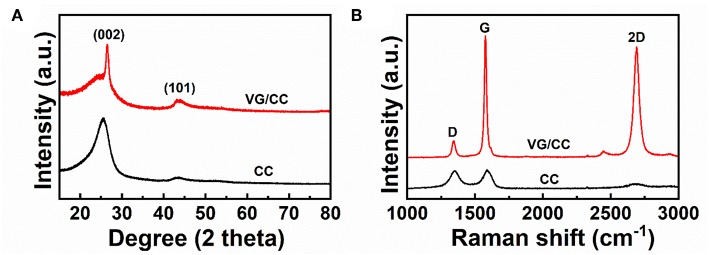
(A) XRD patterns and (B) Raman spectra of the VG/CC and CC.